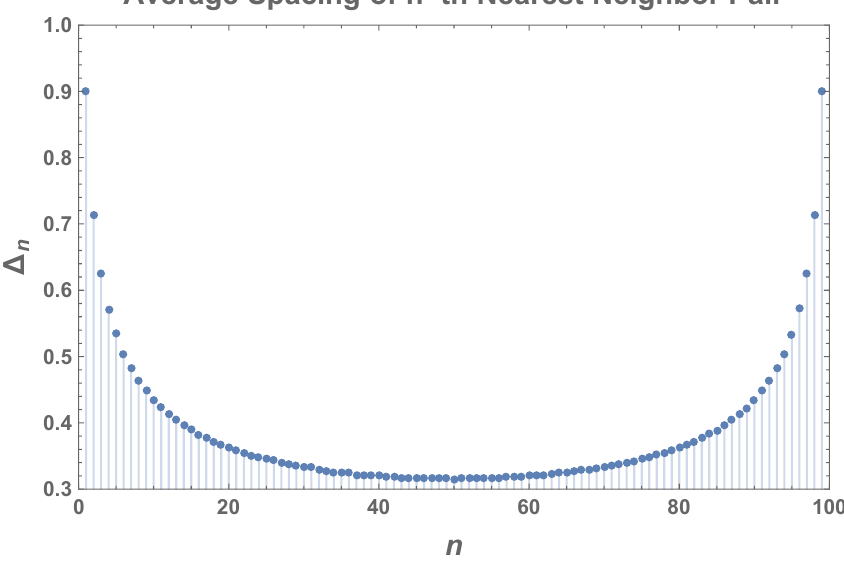
Figure 18 . We plot the average (over 10 5 samples) spacing, ∆ n , between the n -th nearest neighbor pairs of eigenvalues in the GUE ( 100 × 100 matrices). We can see that near the edge of the GUE spectrum, the average spacing between nearest neighbor pairs changes quickly. Near the centre of the spectral density of the GUE the average spacing changes